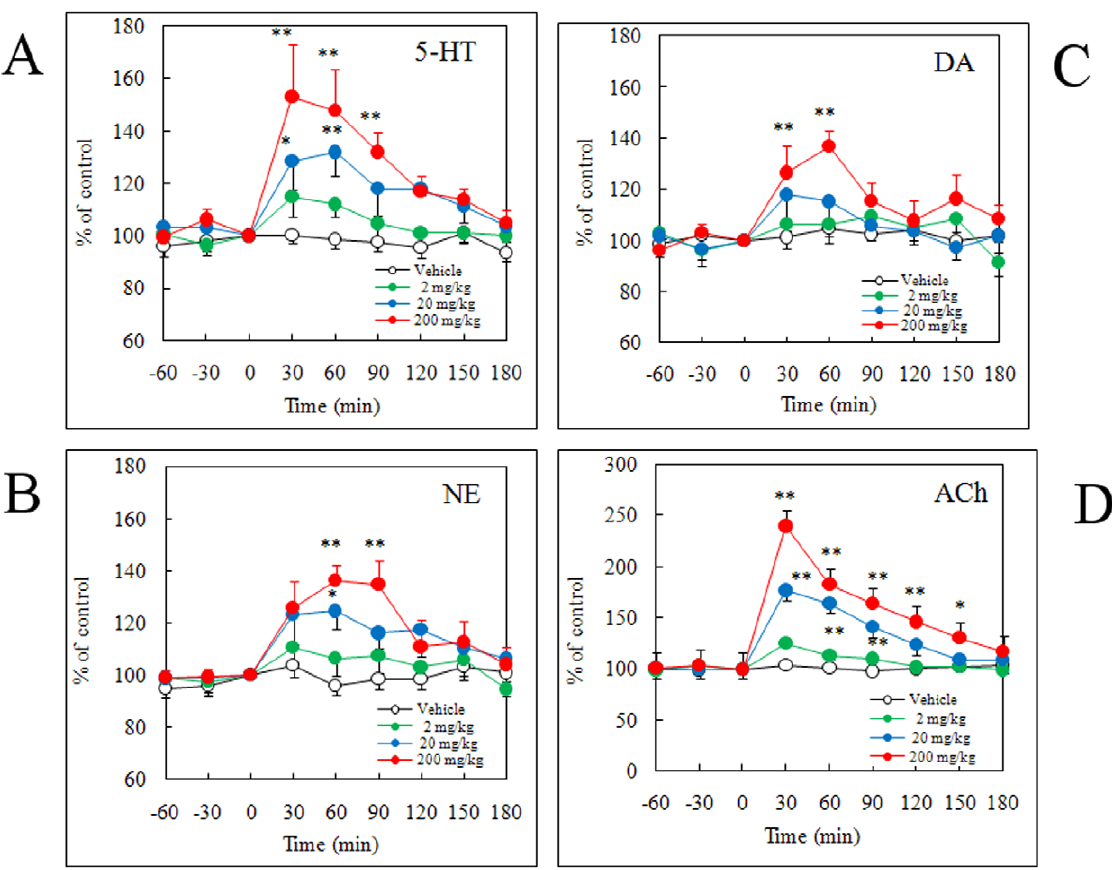
Figure 4. Effects of a 14-day administration of cyclo( L -Phe- L -Phe) on extracellular levels of serotonin (5-HT) (A), norepinephrine (NE) (B), and dopamine (DA) (C) in the medial prefrontal cortex (mPFC) and extracellular levels of acetylcholine (ACh) (D) in the ventral hippocampus (VHIPP) of freely moving rats measured using brain microdialysis. Cyclo( L -Phe- L -Phe) was orally administered to male Sprague–Dawley rats at doses of 2, 20, and 200 mg/kg after sub-chronic treatment for 13 consecutive days once daily at the same doses. Values of the treated groups were compared to that of the vehicle group at respective time points (two-way analysis of variance followed by Bonferroni’s post- test; * P , 0.05, ** P , 0.01. All values are mean 6 standard error, n=6